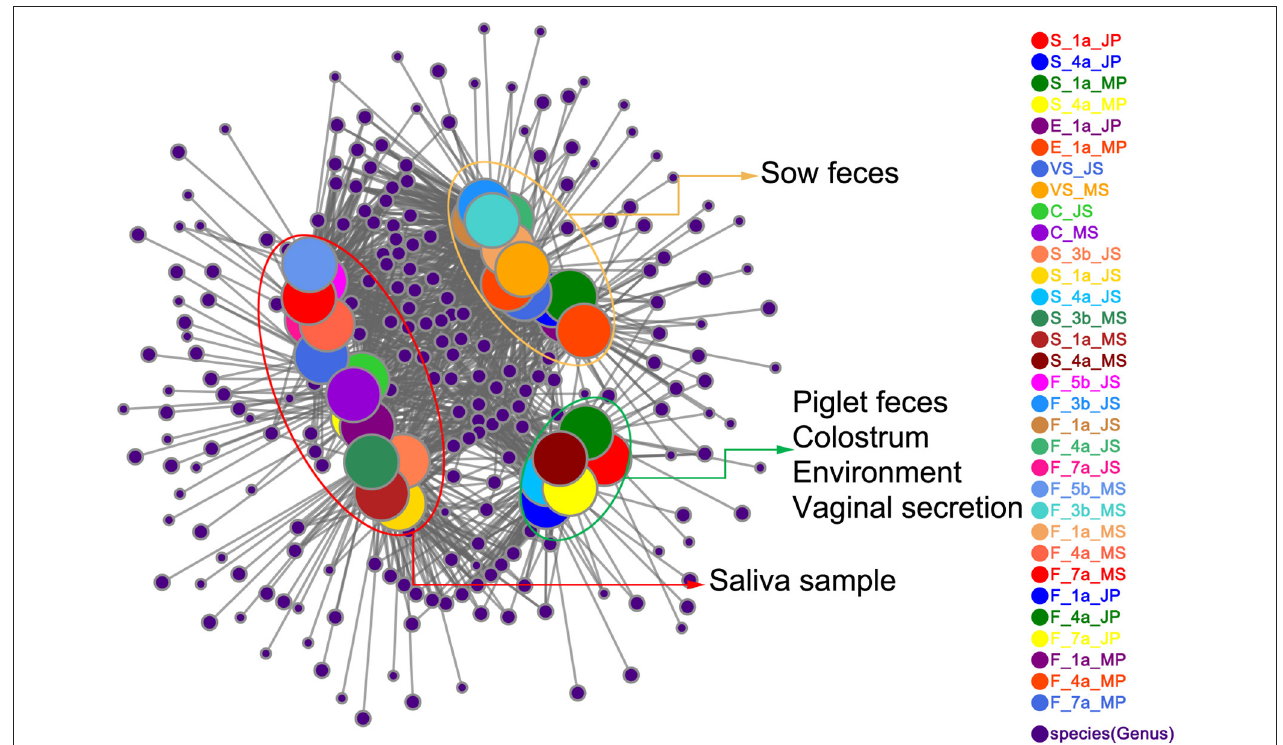
FIGURE 3 | Collinearity network analysis of Jinfen White pig and Mashen pig. Collinear relationships among microbiota of sow and piglet feces, sow and piglet saliva, farrowing bed environment, colostrum, and sow vaginal secretion. The node in the network represents the species node, and the connection between the species node represents that the species is included in the sample. Species with abundance > 50 are displayed by